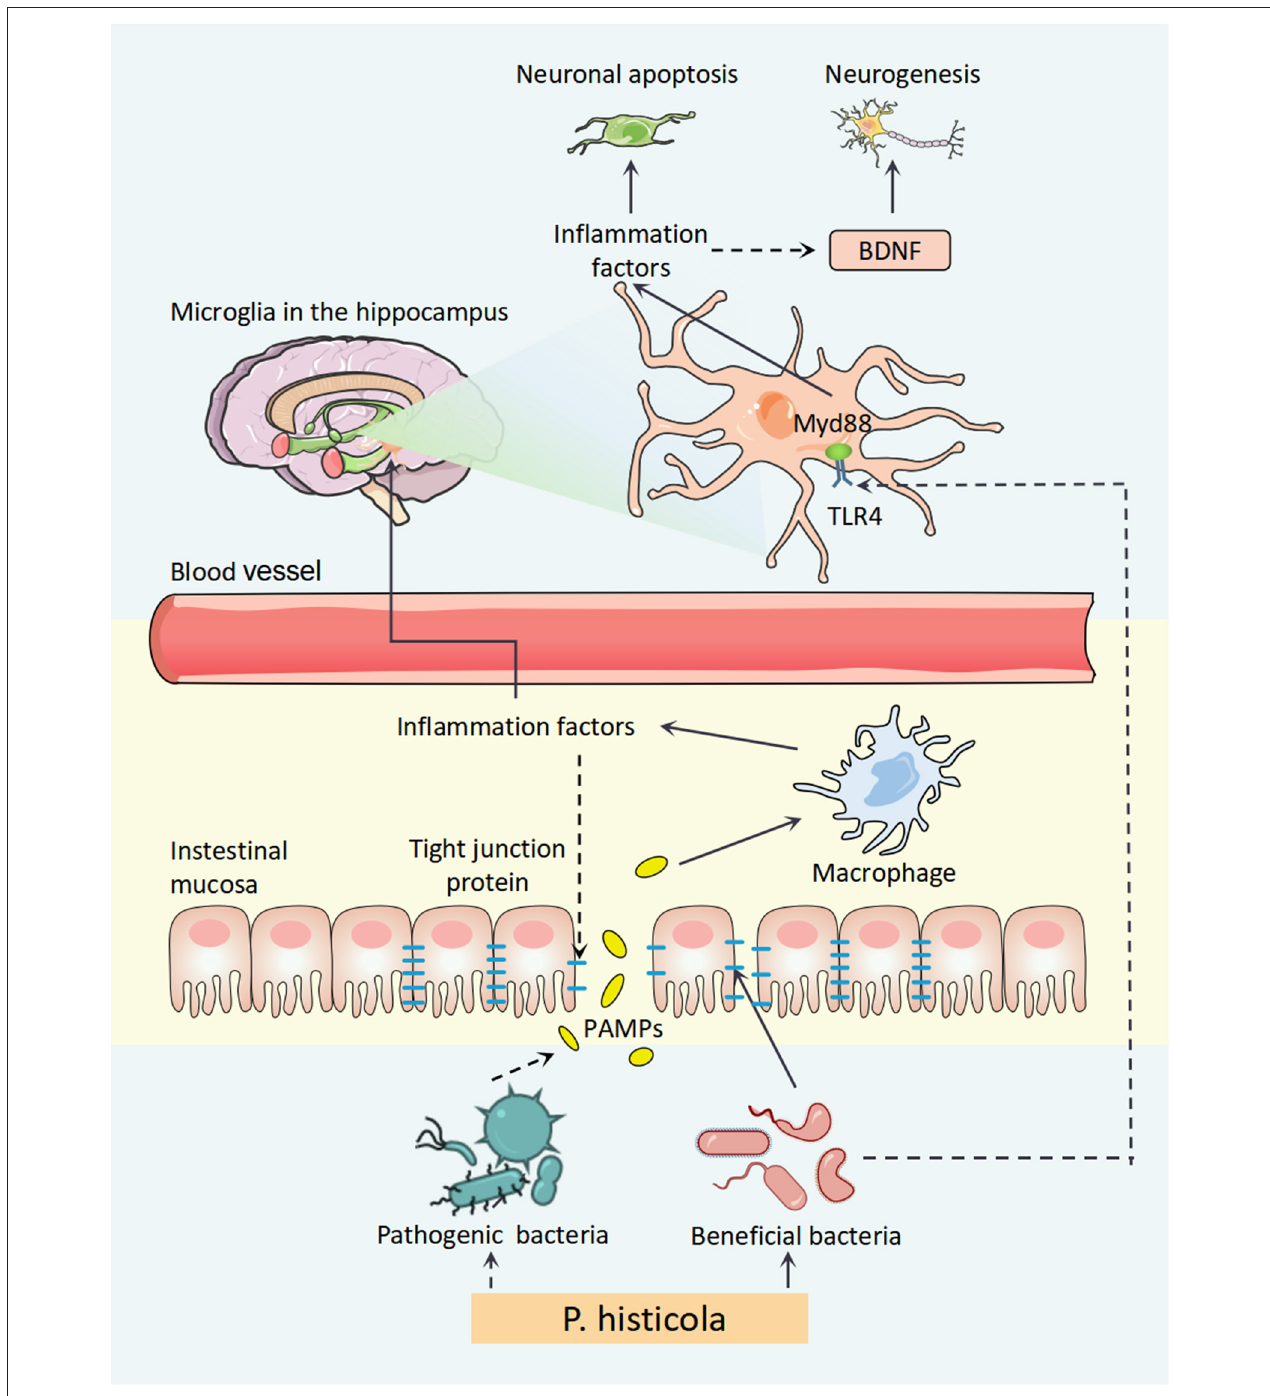
FIGURE 9 | A schematic diagram for the mechanism of P. histicola prevention of estrogen deficiency-induced depression via the microbiota–brain axis. P. histicola treatment exerted a neuroprotective effect through downregulating peripheral and central inflammation, the link of microbiota–gut–brain axis, in estrogen deficiency-induced depression model mice. P. histicola , Prevotella histicola ; PAMPs, pathogen-associated molecular pattern; TLR4, toll-like receptors 4; Myd88, myeloid differentiation factor 88; BDNF, brain-derived neurotrophic factor.